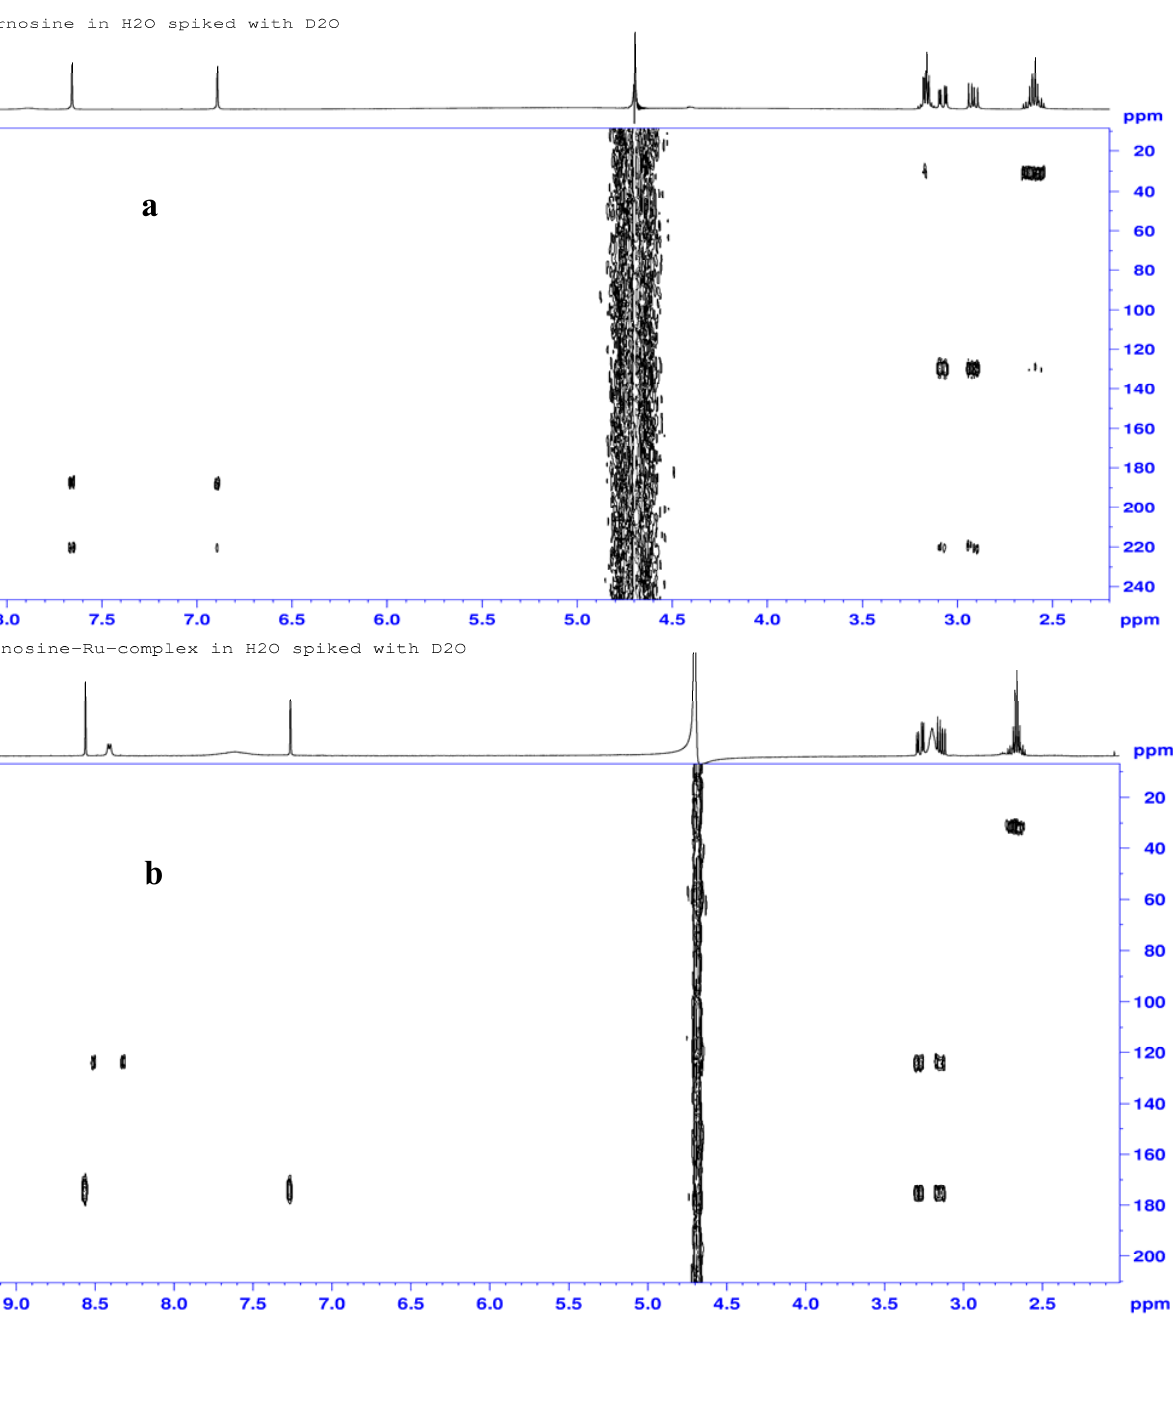
Figure 8. 1 H- 15 N NMR correlation (gHMBC) spectra for L -carnosine ( a ) and Ru-carnosine complex ( b